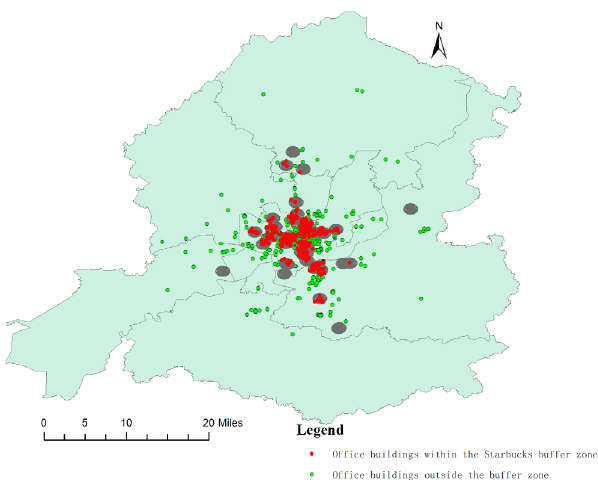
Figure 7. Coverage of Starbucks in office buildings.